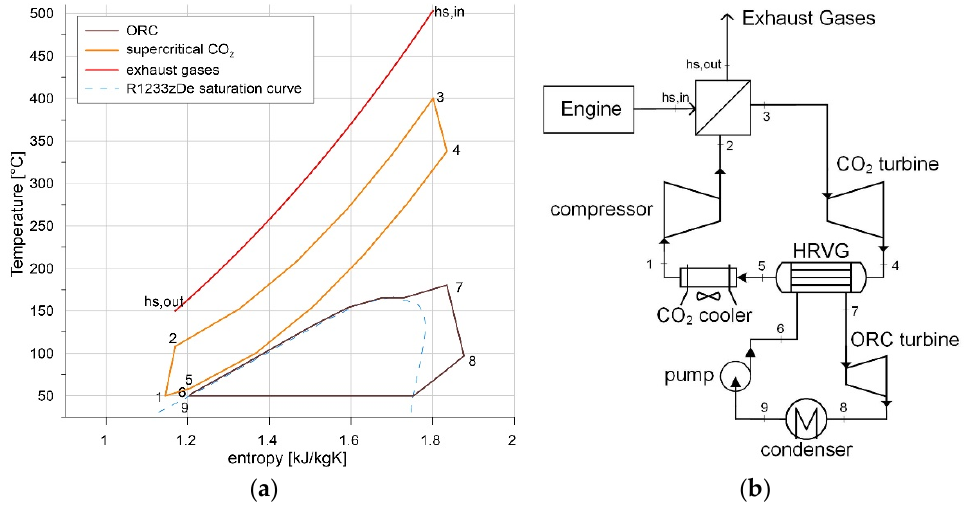
Figure 10. ( a ) example of T-s diagram of a combined energy recovery unit composed by supercritical CO 2 and ORC [162]; ( b ) simple layout of sCO 2 + ORC